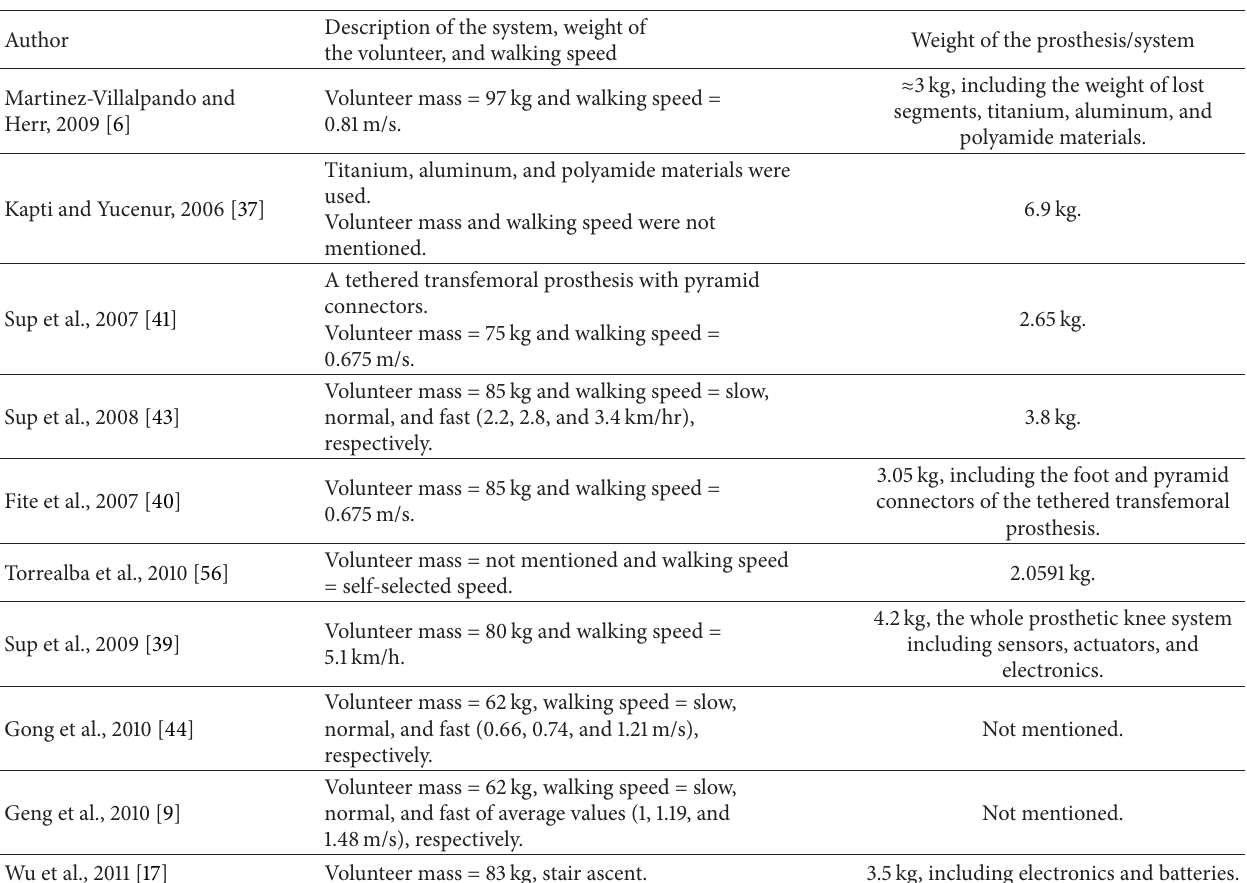
Table 3: Weight of the prosthetic knee